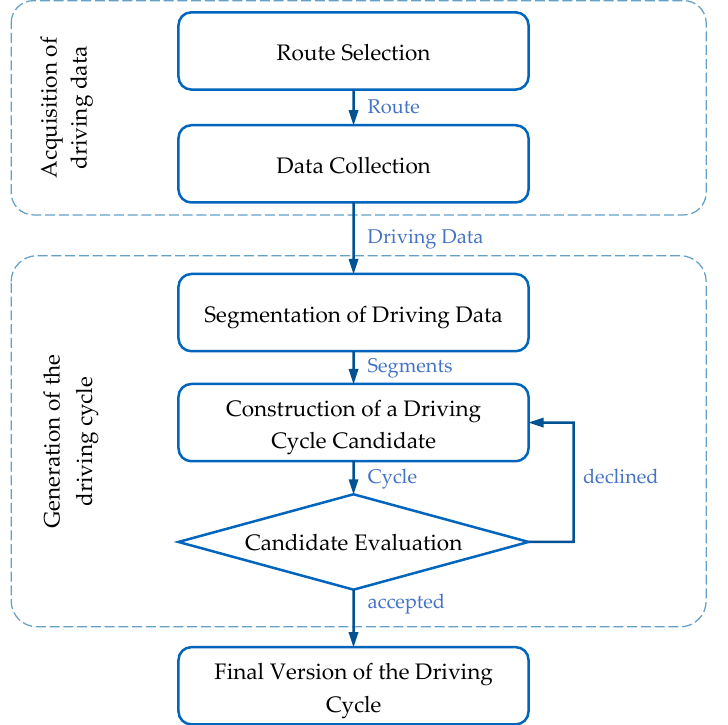
Figure 1. General procedure for driving cycle development using real driving data, based on [16,18].